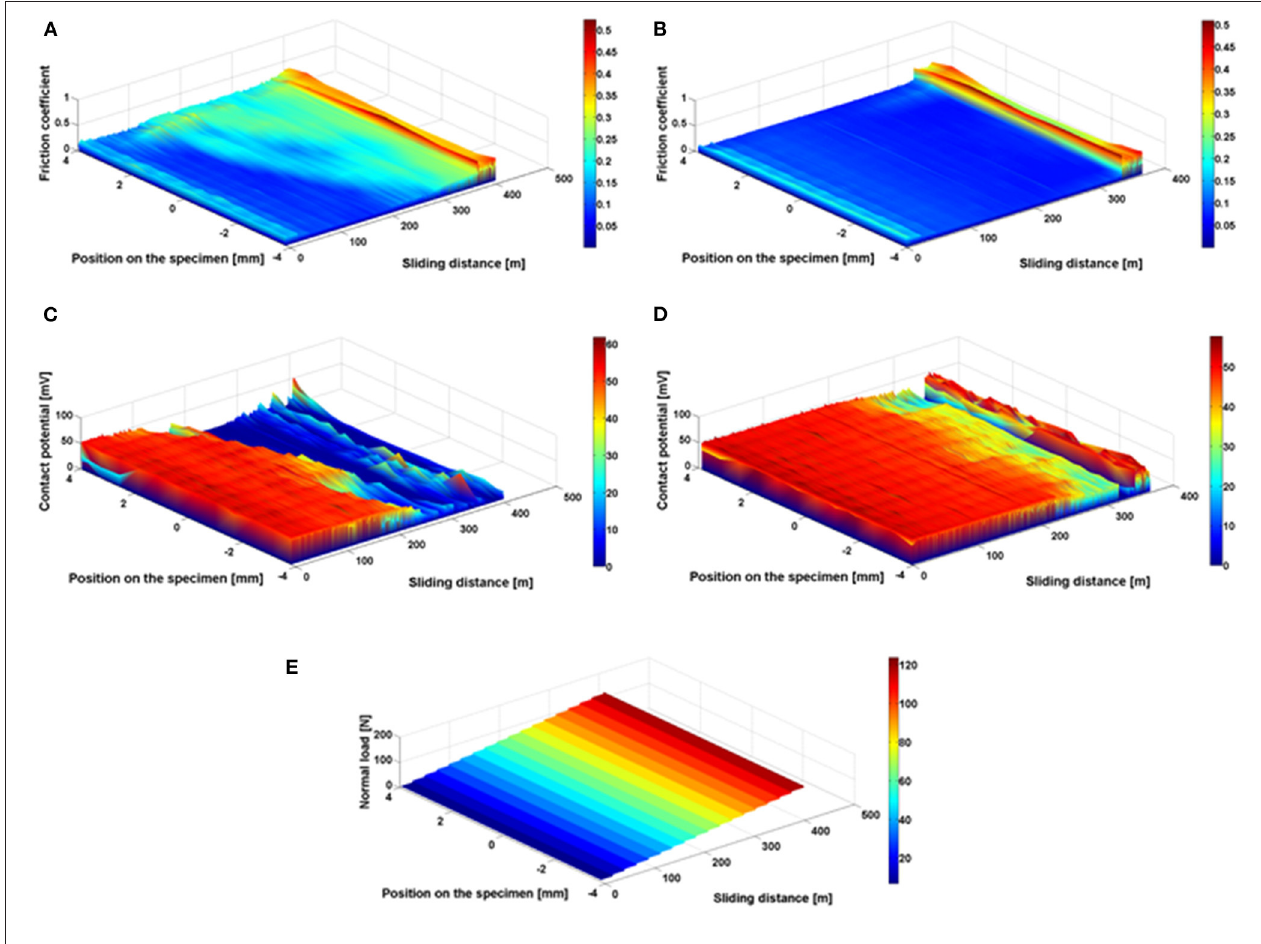
FIGURE 2 | Typical triboscopic maps for the durability tests. (A) Friction coefficient, thick layers. (B) Friction coefficient, thin layers. (C) Contact potential, thick layers; (D) contact potential, thin layers, (E) normal load map ( Lara et al.,